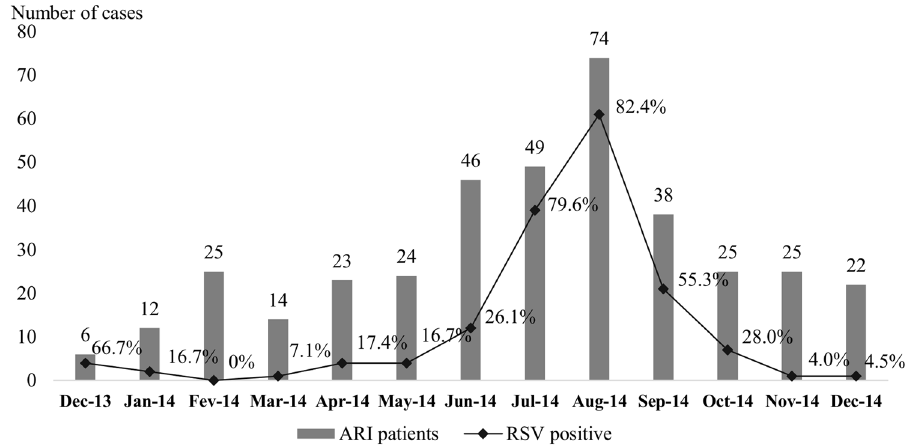
Figure 2. Monthly detection rate of RSV in ARI patients.